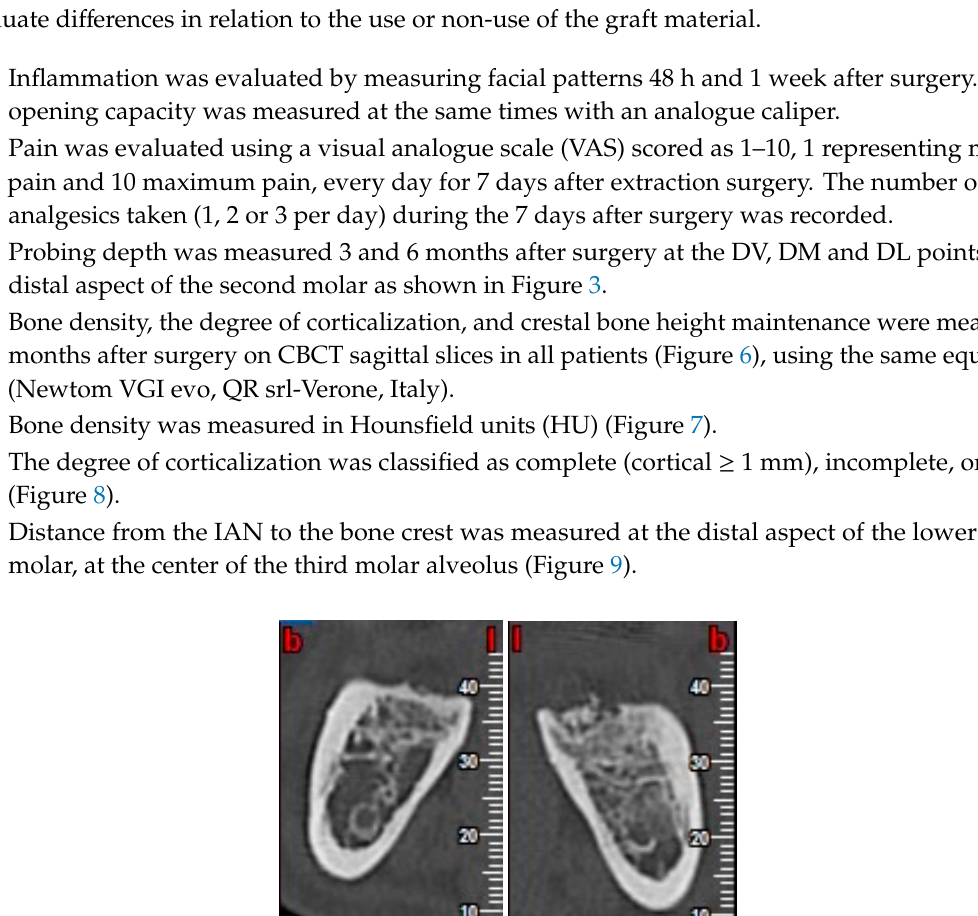
Figure 6. Cone beam computerized tomography scan ( CBCT) scan, taken six months after lower third molar (LTM) extraction, in control group ( a ) and test group ( b ).